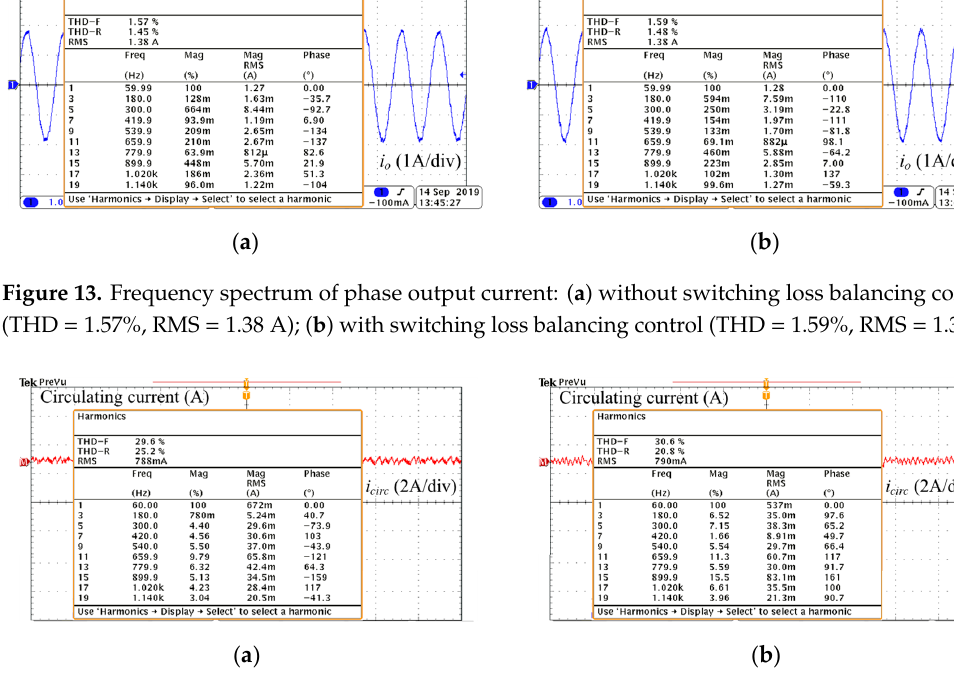
Figure 14. Frequency spectrum of circulating current: ( a ) without switching loss balancing control; ( b ) with switching loss balancing control.